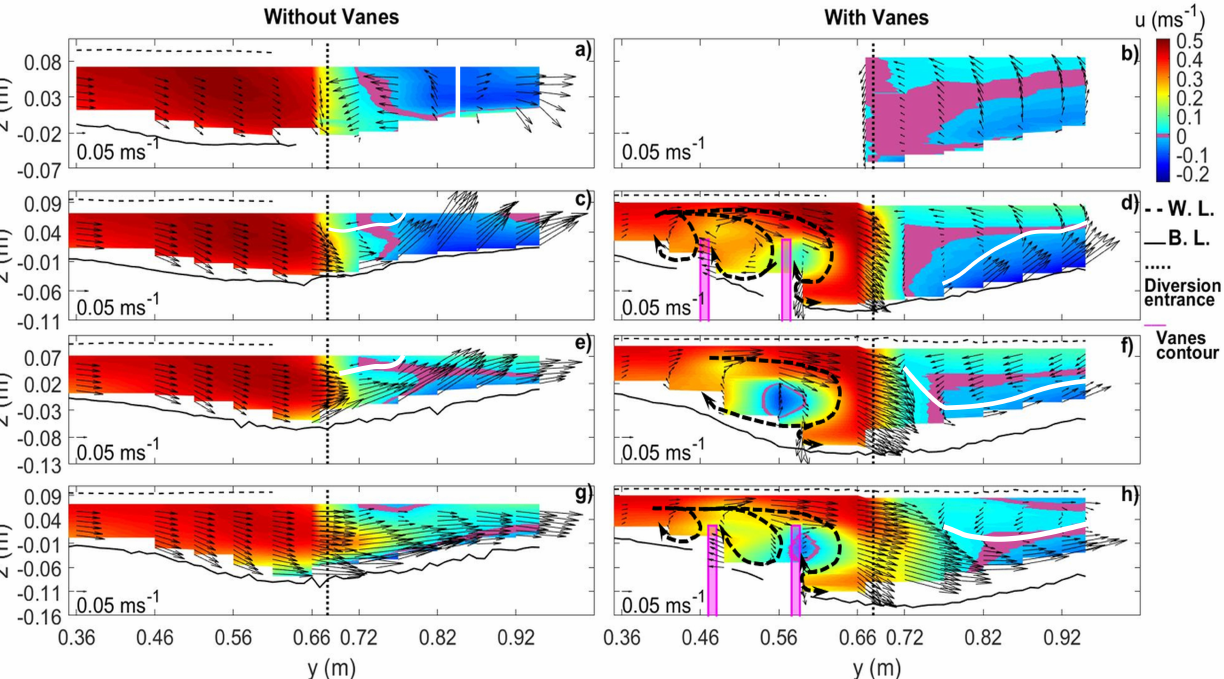
Figure 15. Velocity u (ms − 1 ) as color scale and direction and magnitude of the velocity components ( v , w ) (ms − 1 ) as vector arrows, in the NV and the VF experiments, in the vicinity of and within the diversion entrance, at cross-sections: ( a ) x = 0.02 m. ( b ) x = 0.02 m. ( c ) x = 0.08 m. ( d ) x = 0.08 m. ( e ) x = 0.13 m (middle of diversion). ( f ) x = 0.13 m (middle of diversion). ( g ) x = 0.18 m. ( h ) x = 0.18 m. White lines are tentative representations of the limits of the separation